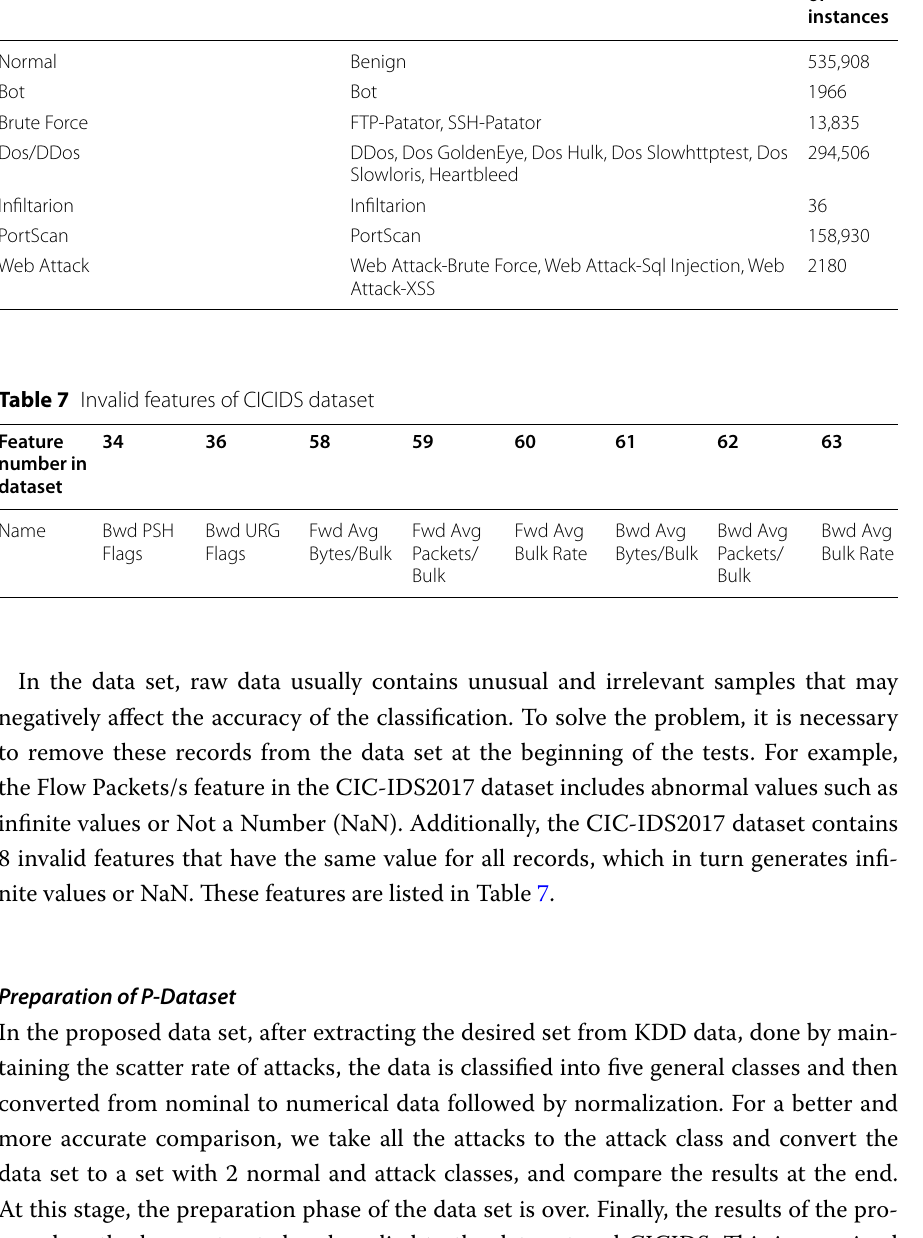
Table 6 New label and the old data label of CICIDS New Labels Old Labels